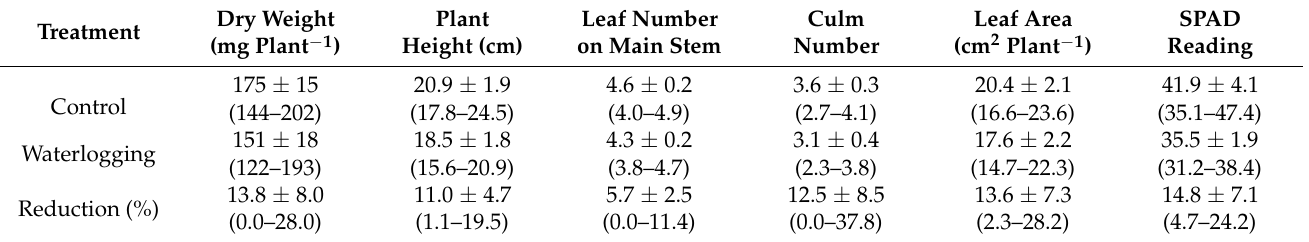
Table 3. Mean and range of agronomic traits of different cultivars under the control and waterlogging conditions and their percentage reduction caused by waterlogging.